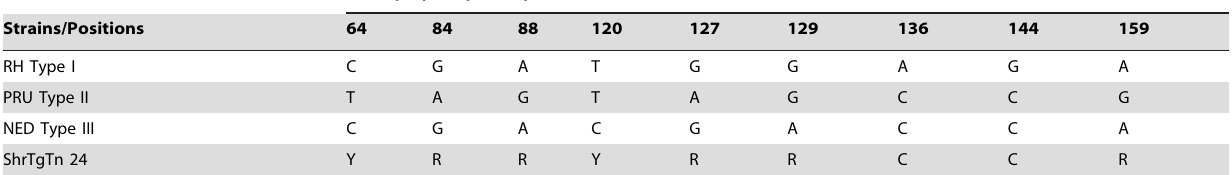
Table 3. Summary of strains polymorphism at SAG3